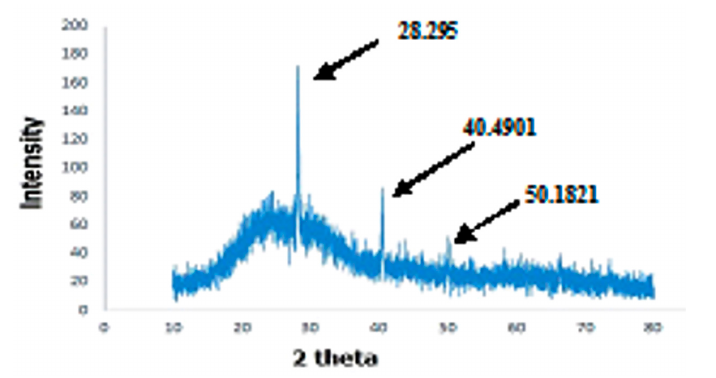
Fig. 6. X-Ray Diffractometer pattern of TiNPs Table 2. Bioactivity of TiNPs against certain bacteria Compound Stapylococcus Steptococcus Staphylococcus Bacillus Escherecia Klebsiella aureus spp. Epidermidis Sp. coli spp. Banana Peels Extract (BPE) 6 18